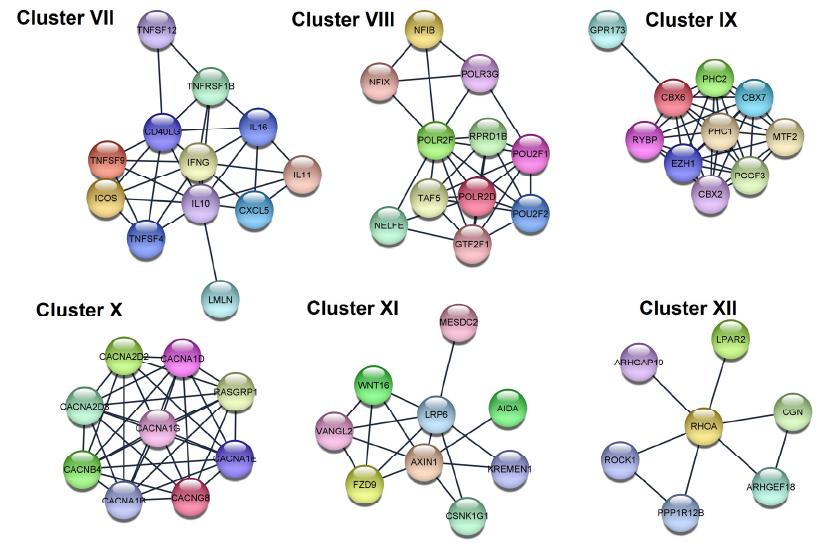
Figure 8. Results of protein–protein interaction analysis. The six top-scored clusters separated from PPI network of the genes regulated by upregulated miRNAs found in the current study. Table 5. Enrichment analysis of the six top-scored clusters separated from the PPI network of the genes regulated by upregulated miRNAs found in the current study. Cluster Category